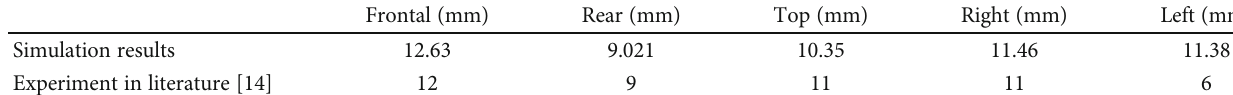
Table 3: BFD values of di ff erent impact directions compared with the literature.